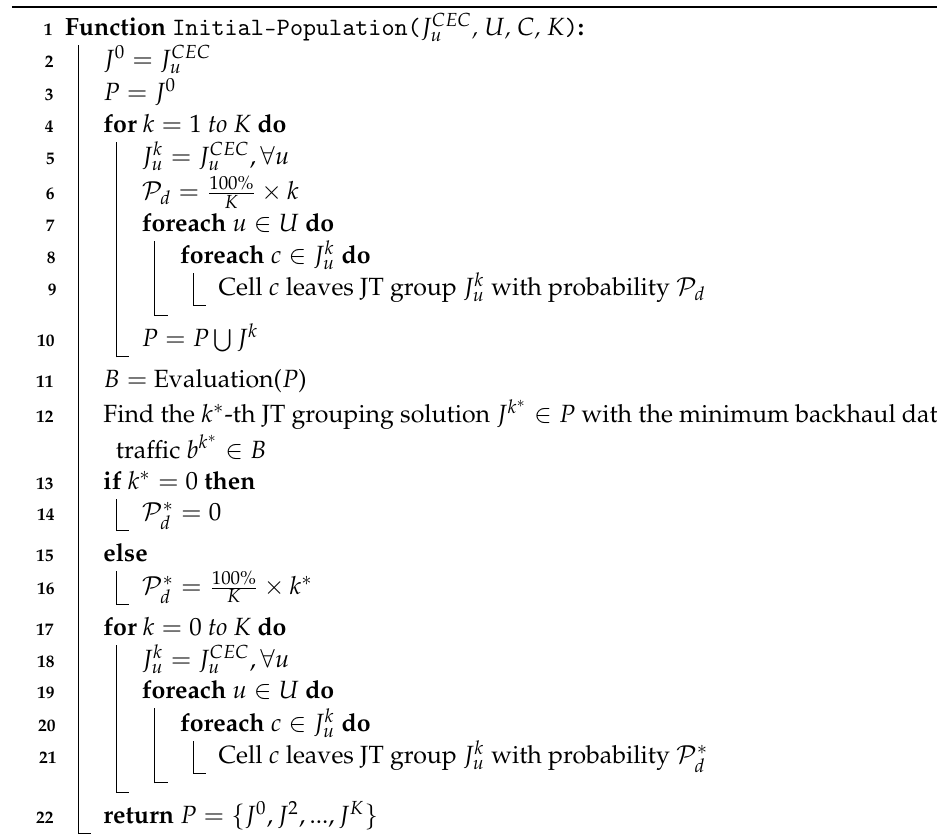
Algorithm 2: Initial-Population()